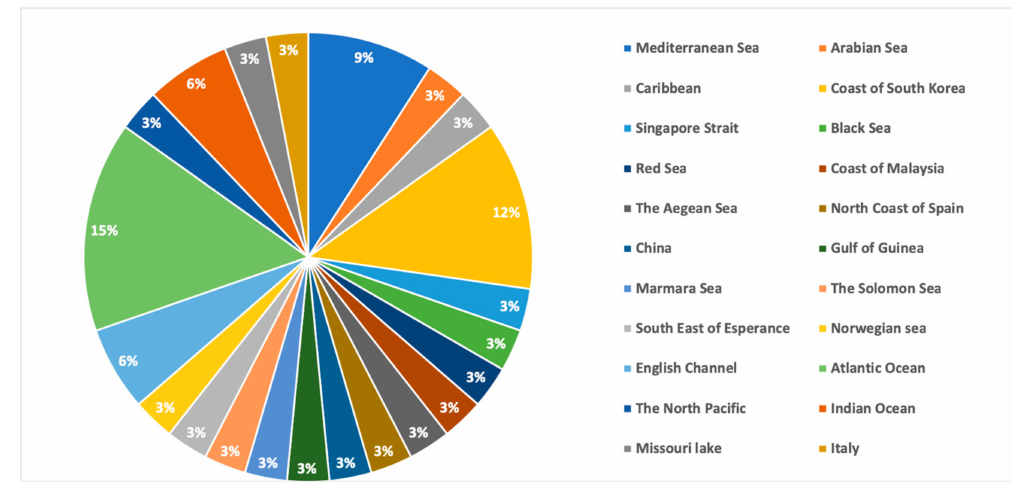
Figure 4. The locations of maritime accidents due to vulnerabilities of integrated bridge system (IBS) digital